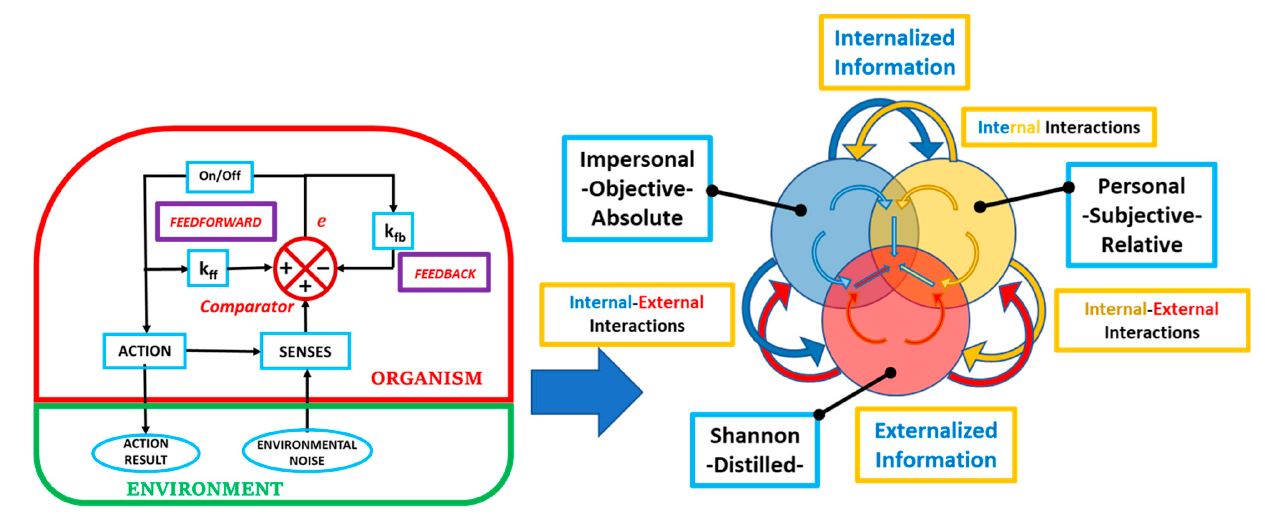
Figure 2. The living-being-in-its-environment and info-autopoiesis.